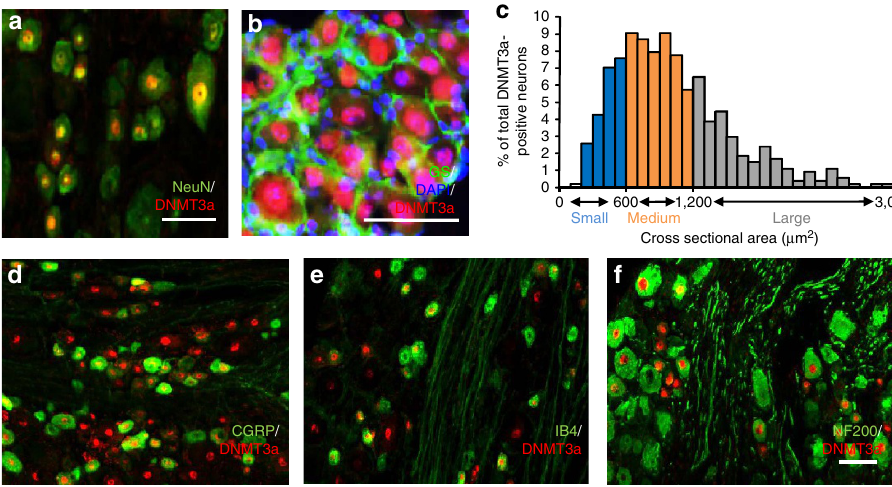
Figure 1 | Distribution of DNMT3a protein in lumbar dorsal root ganglia of naive rats. ( a , b ) DNMT3a is co-expressed exclusively with NeuN in cellular nuclei ( a ) and undetected in cellular nuclei (labelled by 4 0 , 6-diamidino-2-phenylindole (DAPI)) of glutamine synthetase (GS)-labelled cells ( b ). ( c ) Distribution of DNMT3a-positive somata: large, 30.2%; medium, 48.2%; small, 21.6%. ( d – f ) DNMT3a-positive neurons were labelled by calcitonin gene-related peptide (CGRP; d ), isolectin B4 (IB4; e ) or neurofilament-200 (NF200; f ). n ¼ 5 rats. Scale bars, 50 m m.